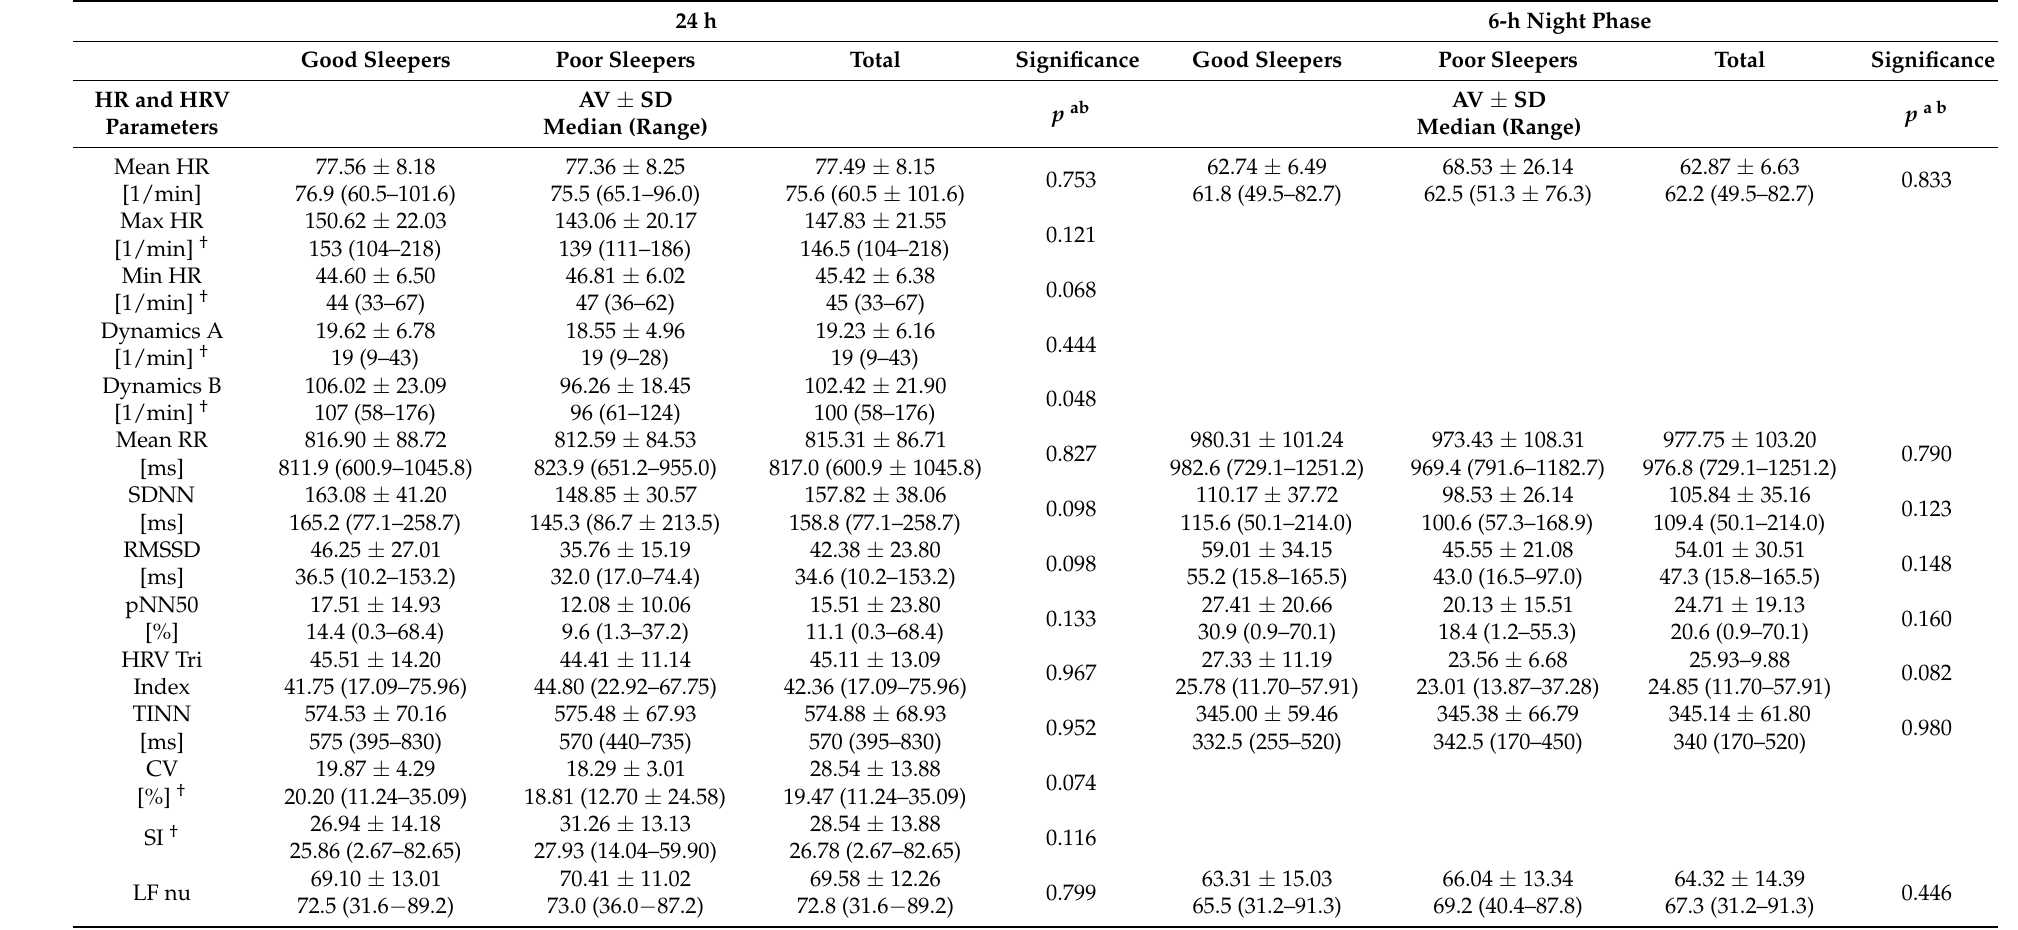
Table 3. Comparison of HR and HRV parameters in the 24-h time frame and six-hour night phase of both